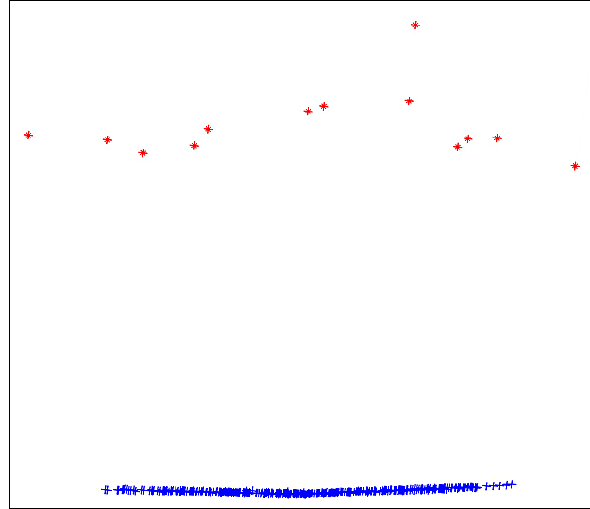
Figure 5. Camera positions and reconstruction (image set 4).